Question: Does the plotted quantity increase or decrease?
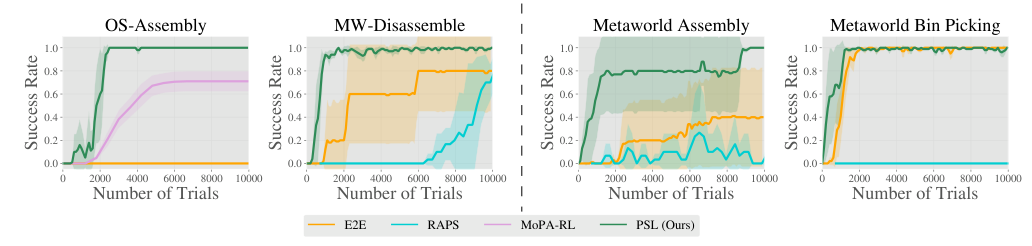
Answer: increasing